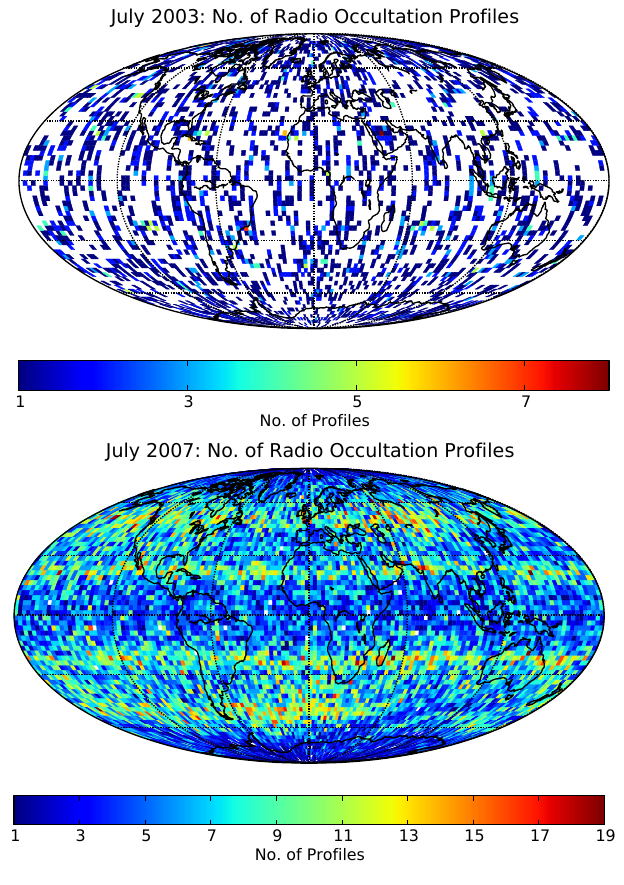
Fig. 2. Global monthly coverage of RO profiles for July 2003 (top) single-satellite (CHAMP) and for July 2007 (bottom) multi-satellite data (CHAMP, COSMIC, GRACE-A). Number of profiles in 2 . 5 ◦ × 2 . 5 ◦ bins are